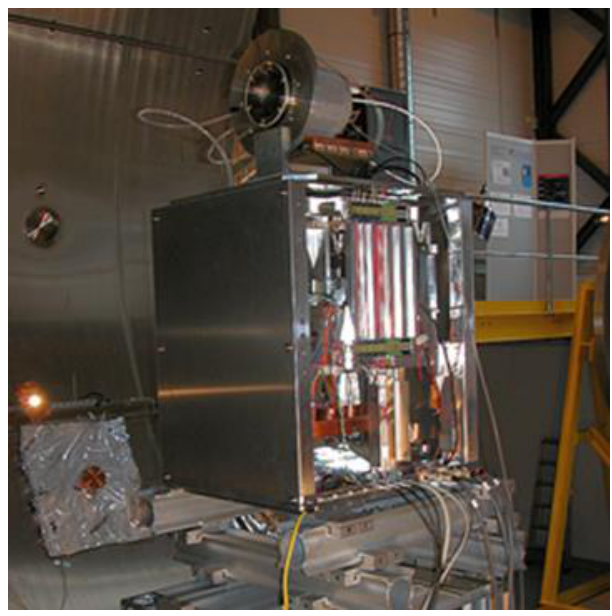
Figure 3: Thrust balance with open lid on one side. A gridded ion thruster is mounted on the balance. Figure 3 shows the thrust balance and a gridded ion thruster mounted on it. The balance can carry a single thruster or arrays with a mass of up to 40kg. To minimize hysteresis or other unwanted effects, cables and tubes feeding the thruster are routed in a holder configuration called ‘cable harp’. Herein the length of cables and tubes are adjusted so that the distance between their bending points is the same as the distance between corresponding balance